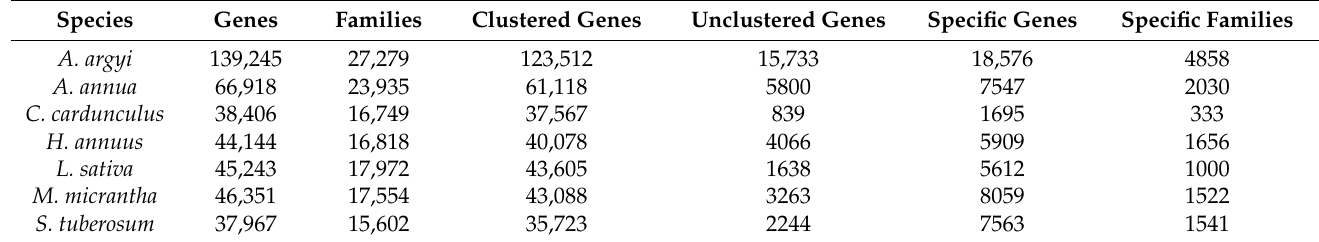
Table 1. Comparison of gene number of A. argyi and other